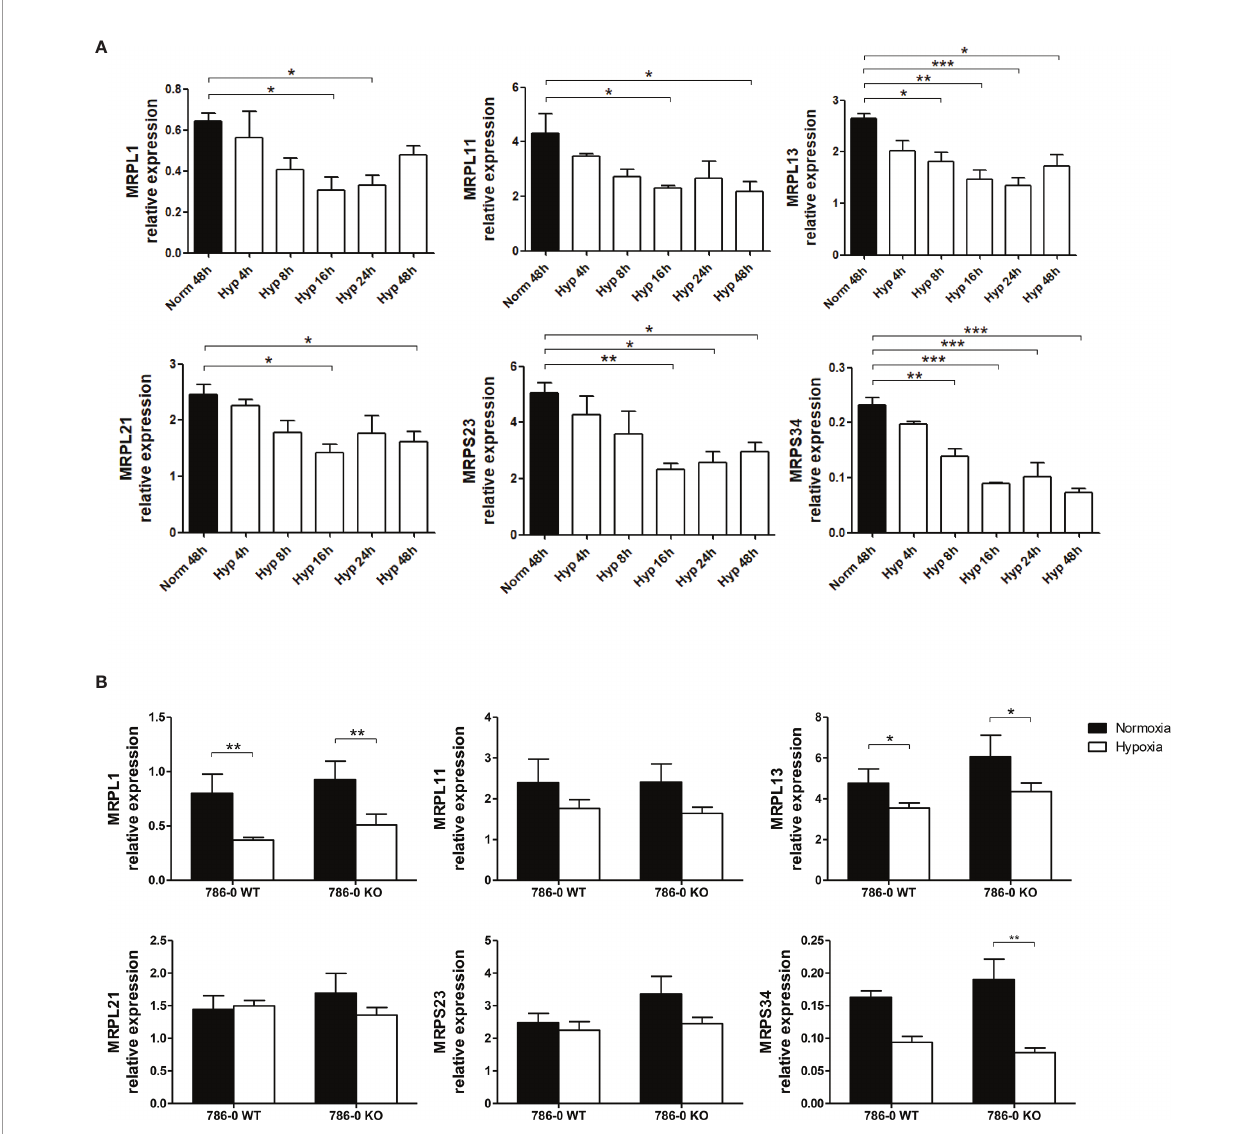
FIGURE 7 | Expression of mitochondrial ribosomal proteins (MRPs) is downregulated under hypoxia. (A) RNA expression of MRPs involved in mtRNA translation in MCF7 cells cultured in normoxia or 0.1% hypoxia for 4h, 8h, 16h, 24h and 48h was evaluated by qPCR (n=3). (B) MRPs mRNA expression in 786-0 WT and 786-0 KO cells cultured in normoxia or 0.1% hypoxia for 48h was also evaluated by qPCR (n=3). Number of replicates indicate biological replicates and data is shown as mean ± SEM. *p < 0.05, **p < 0.01, ***p <